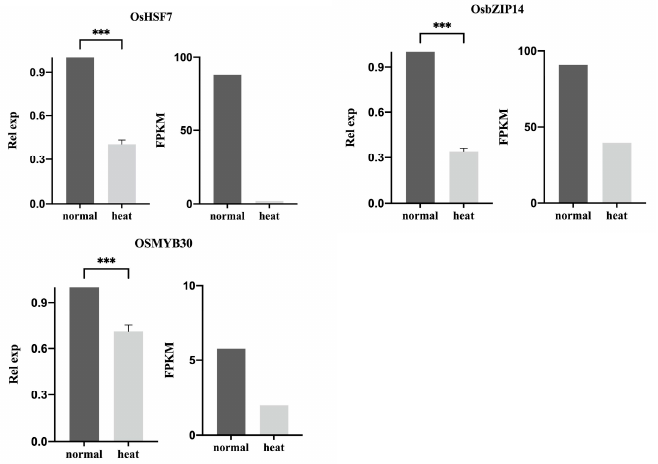
Figure 4. Expression of OsHSF7, OsbZIP14, and OsMYB30 by using RT-qPCR and RNA-seq methods. The plot on the left side represents the RT-qPCR measurement results, while the right side represents the RNA-seq analysis results. The statistical significance of the expression changes was determined using the student t -test, ‘***’ indicating a p -Value <